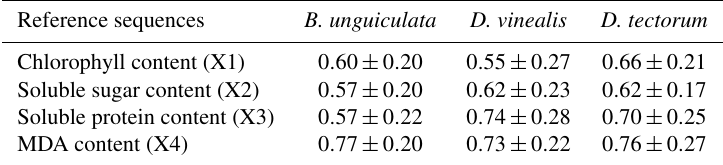
Table 4. Gray incidence degree between physiological indices and the gametophyte vigor index across all